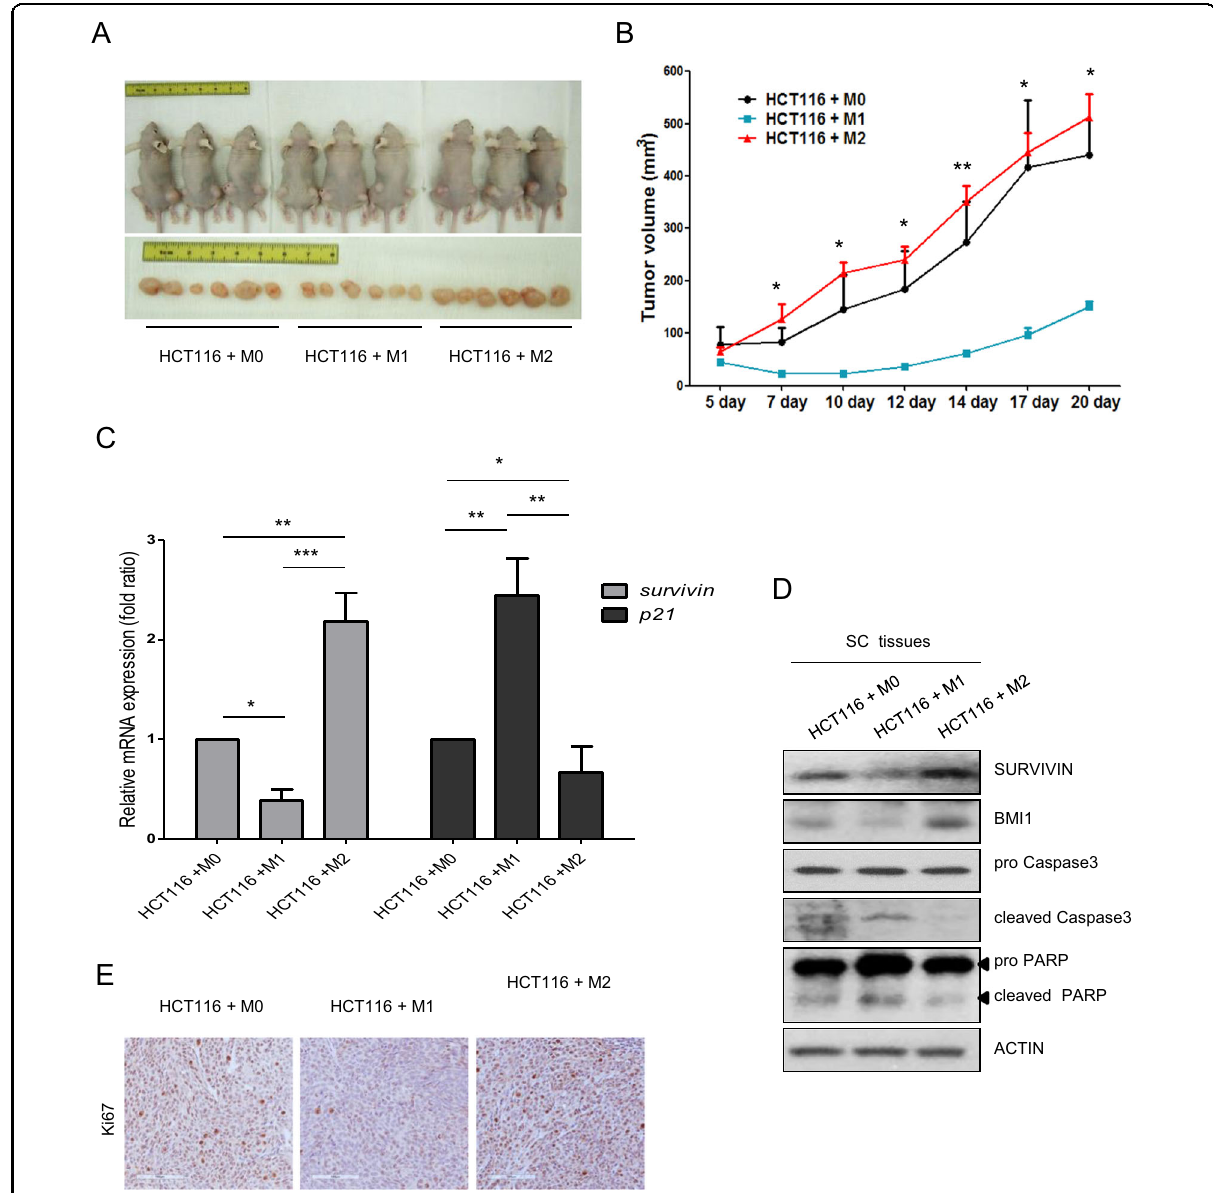
Fig. 2 Opposite effects of M1 and M2 macrophages on tumor growth. a Tumor images and b tumor growth 3 weeks after transplantation of HCT116 cells after long-term coculture with differentiated M0, M1, or M2 macrophages (see Materials and Methods). Tumor size was measured 2 – 3 times a week with a caliper. Tumor volume was calculated using the following formula: tumor volume = (short length × long length × width)/2. The expression of SURVIVIN or p21 c ) and proliferation markers d in mouse subcutaneous tissues was evaluated by real-time PCR and western blotting, respectively. e Ki67 staining (1:200) of mouse subcutaneous tissues three weeks after subcutaneous injection. Scale bar: 100 μ m. The results shown are presented as the mean ± SD from three mice per group. Actin was used as a loading control. * P < 0.05; ** P < 0.01; *** P <